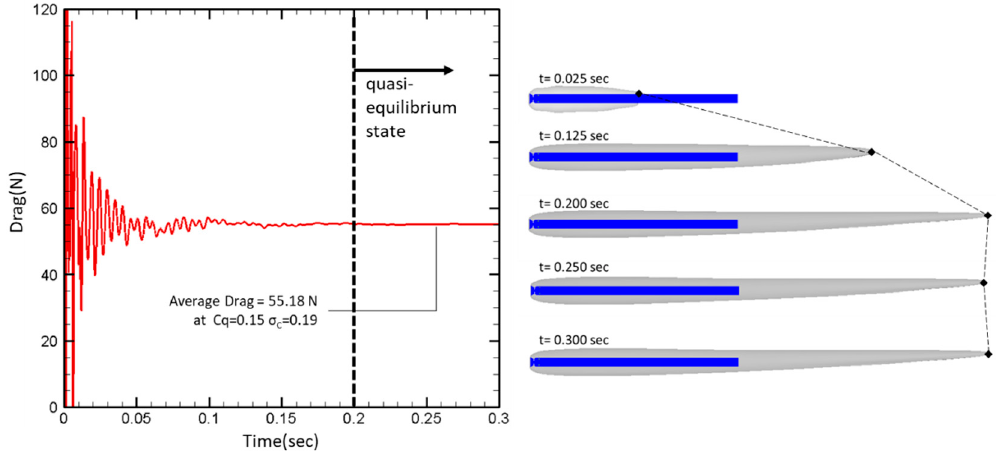
Figure 11. Result of computational analysis of drag change and cavitation shape over time (Cq = 0.152).